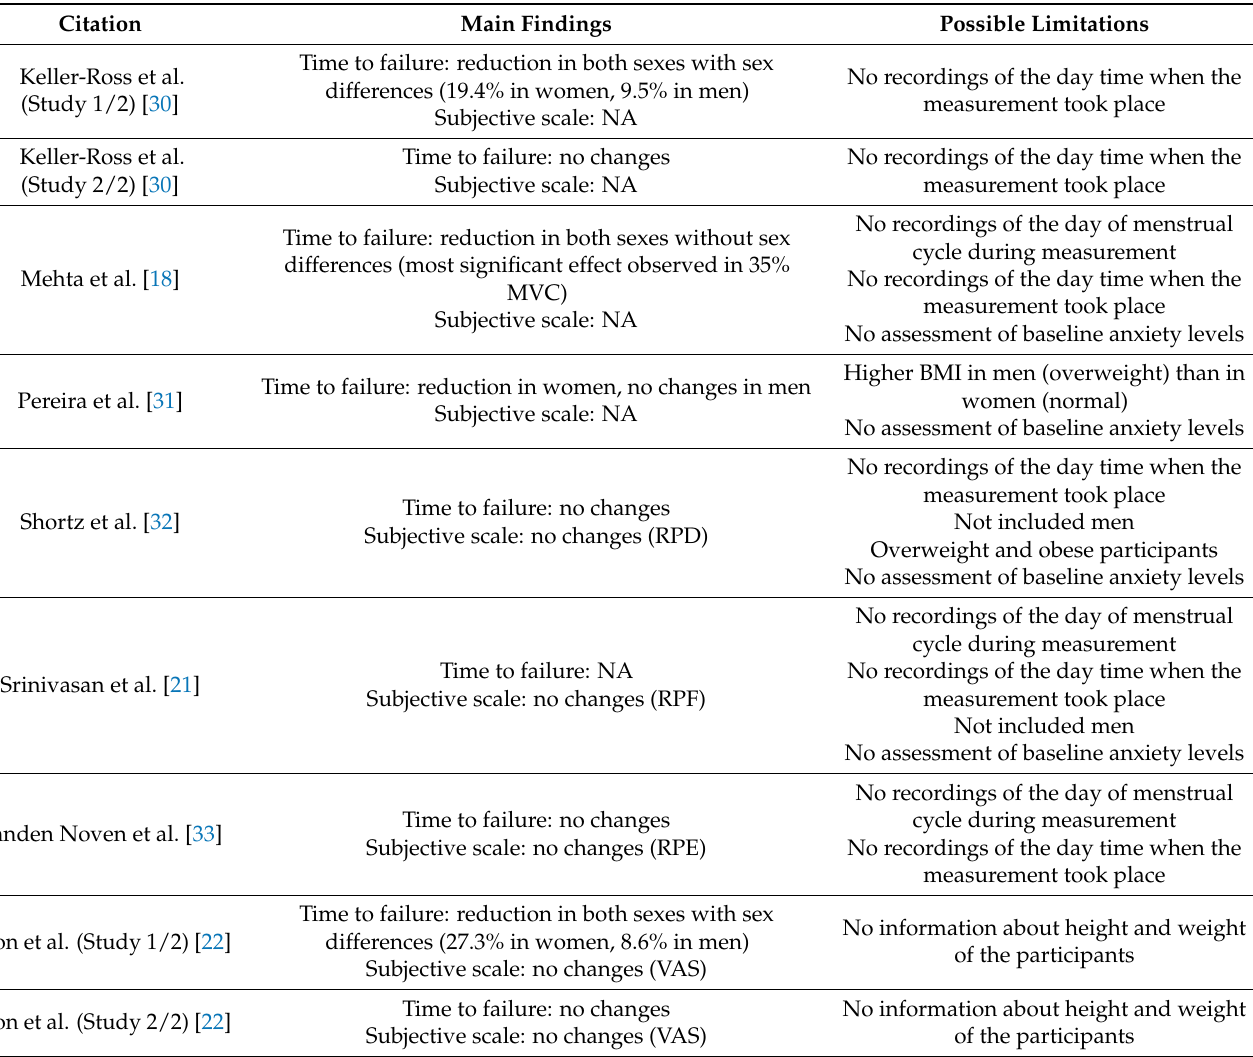
Table 3. Main findings and possible limitations of each